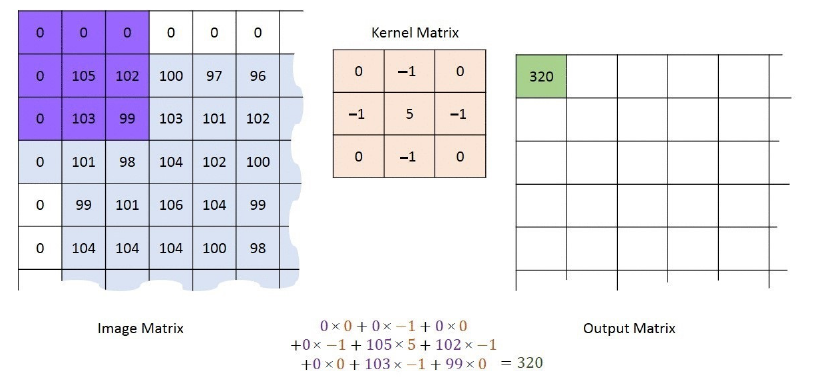
3 kernel matrix for one pixel at the RD-HR map. ×